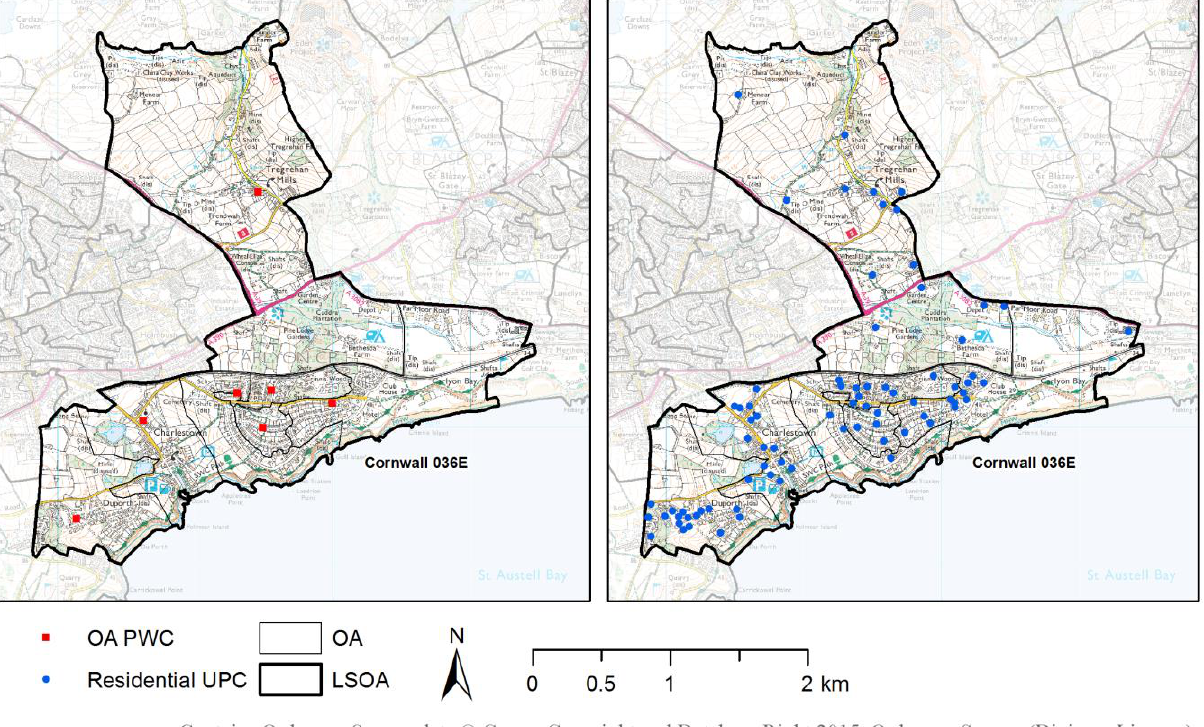
Figure 3 An exemplar study area LSOA showing constituent OAs, OA PWCs and